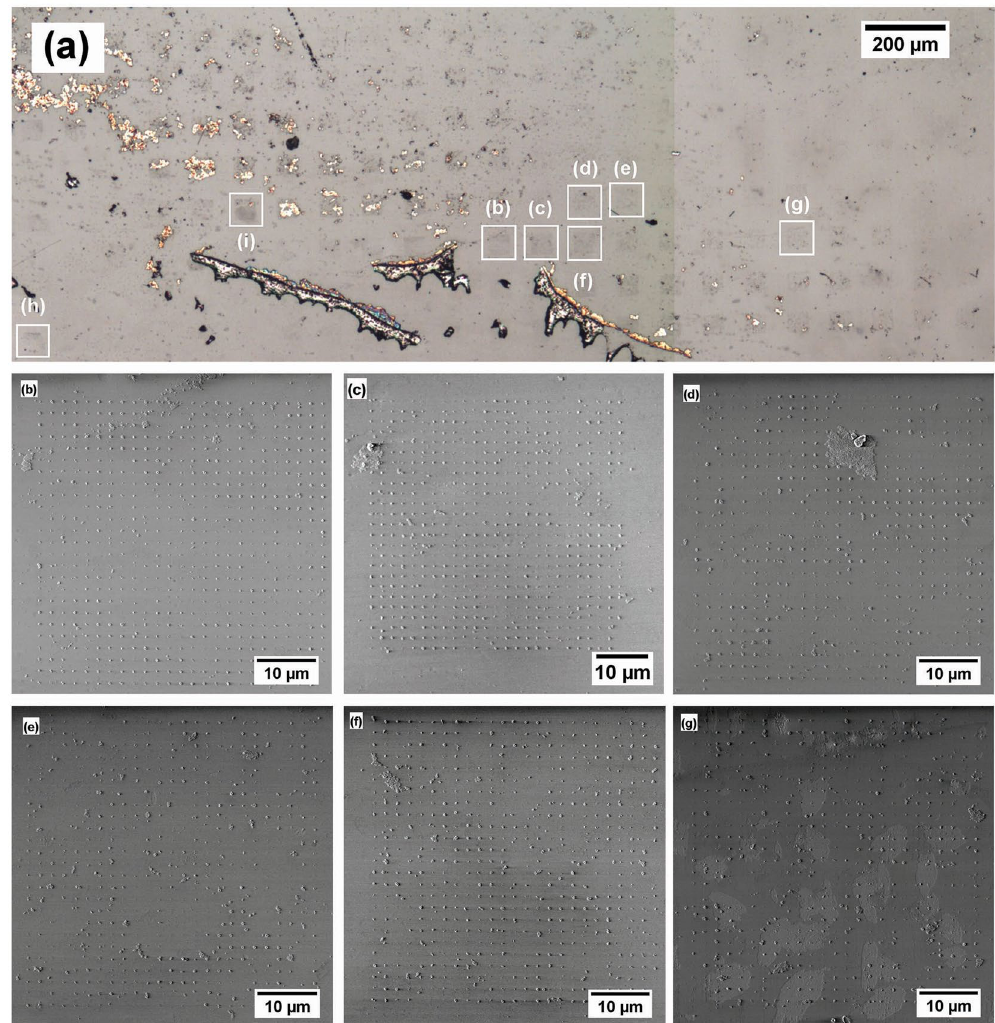
Figure 1. Composite optical micrograph ( a ) and individual SEM micrographs ( b – g ) of nanodiamond arrays on a glass substrate. The pitch from array to array is 50 μ m. Arrays ( h ) and ( i ) were studied by SEM and confocal microscope. Arrays ( b – g ) were only imaged by SEM. Each array has 623 sites (25 × 25 with 2 on the lower right corner omitted for orientation purposes) and a pitch of 1.5 μ m. The degree to which the self-assembly was successful has been quantified by eye and is shown in Table 1.